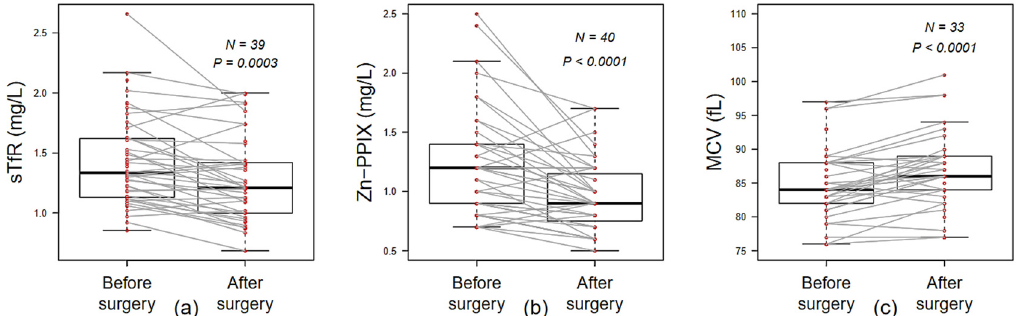
Figure 3. Iron availability for erythropoiesis. Paired comparison of pre- and post-operative erythroid iron-related markers values: ( a ) soluble transferrin receptor (sTfR, mg/L), ( b ) erythrocyte porphyrin (Zn-PPIX, µmol/mmol of red blood cells) ( c ) mean corpuscular volume (MCV, fL). Wilcoxon paired test.